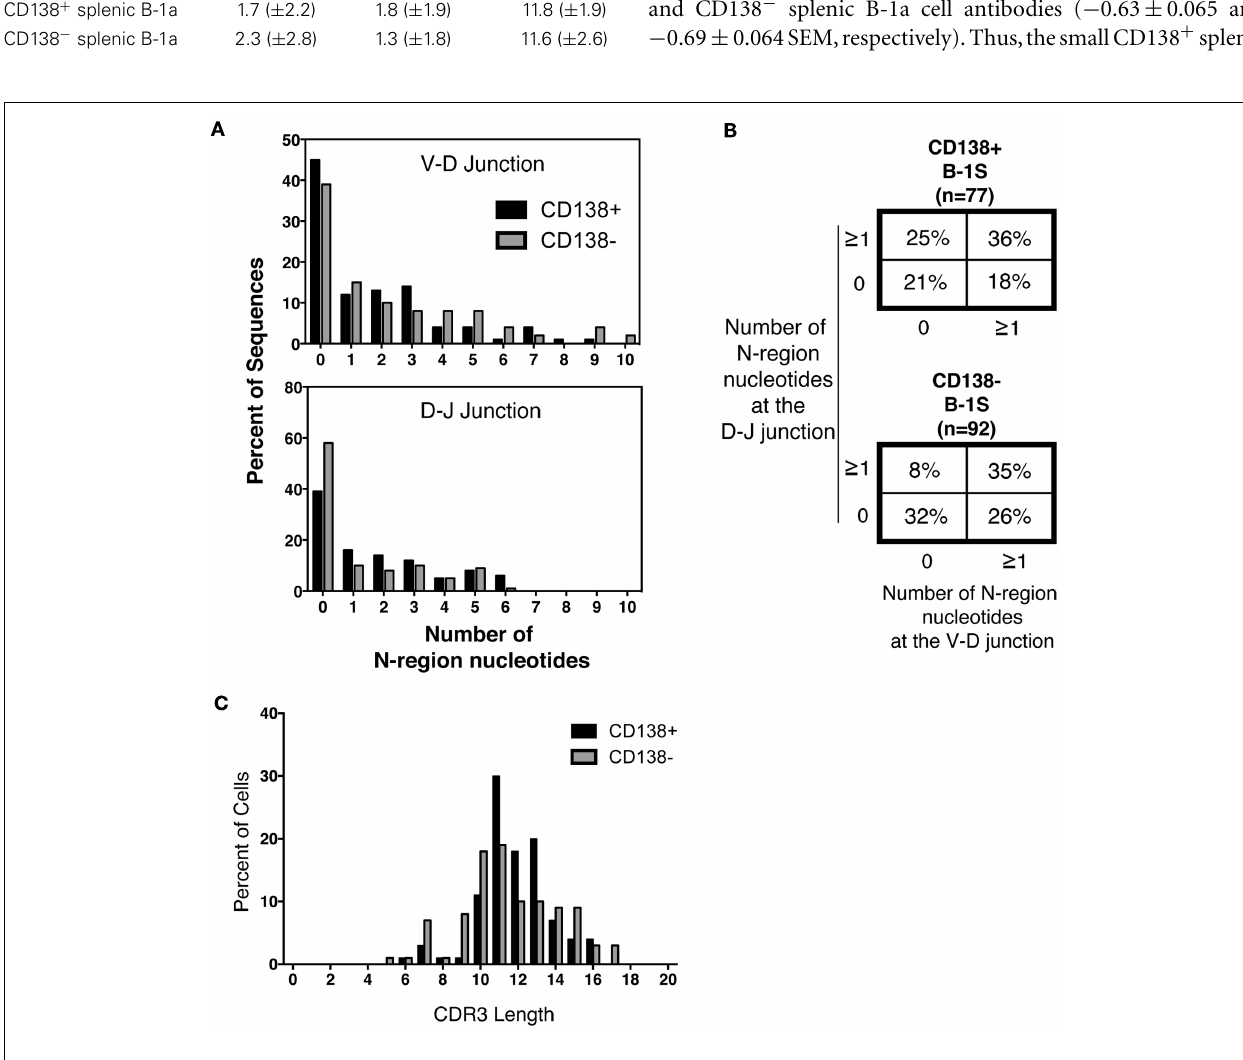
sequences with 0–10 N-additions at each junction for CD138 + (black bars) and CD138 − (gray bars) splenic B-1a cells. (B) N-addition analysis of the V–D and D–J junctions together. (C) CDR3 length analysis of immunoglobulin sequences from CD138 + (black bars) and CD138 − (gray bars) splenic B-1a